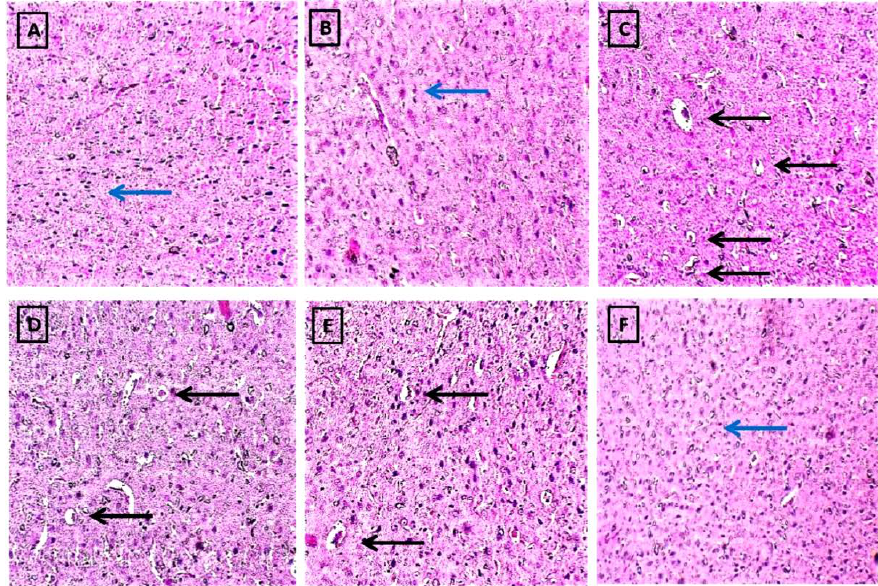
Figure 13. FSK prevents histopathological alterations in the striatal brain region in the experimental model of PD. Staining of the striatal brain sections with haematoxylin and eosin (H and E) reveals changes in neuronal cell density, dopaminergic neuron loss and the presence of Lewy bodies. Dopaminergic neuron loss causes neuronal degeneration and the formation of Lewy bodies in the rat brain. On the slides, the blue arrow represents neuronal density, while the black arrow represents the formation of Lewy bodies. (A) The diagram depicts the naive group, which has a high density of neuronal cells. (B) The diagram depicts the FSK per se group, and there was no significant difference in neuronal cell density between the naive and naive + FSK groups. (C) Diagram of the 6-OHDA group in which Lewy bodies are formed with low neuronal density. (D–F) The diagram compares FSK 15, FSK 30 and FSK 45 to the 6-OHDA-treated group, which had significantly less Lewy body deposition and neuronal degeneration. (F) The FSK 45 group had a higher restoration frequency of neurons with a higher neuronal den- sity than the FSK 15 and 30 groups. 3. Discussion 6-OHDA is a neurotoxin that inhibits complexes I and IV, causing mitochondrial dysfunction and, eventually, the death of catecholaminergic neurons (DA, adrenaline and noradrenaline) [35]. It does not penetrate the blood-brain barrier and is injected di- rectly into the brain using stereotaxic surgery. An increasing body of research has shown that 6-OHDA induces motor impairment [21]. MWM and EPM were employed in this study to investigate memory and cogni- tion-related behavioural activities. Rats given 6-OHDA had considerable learning and